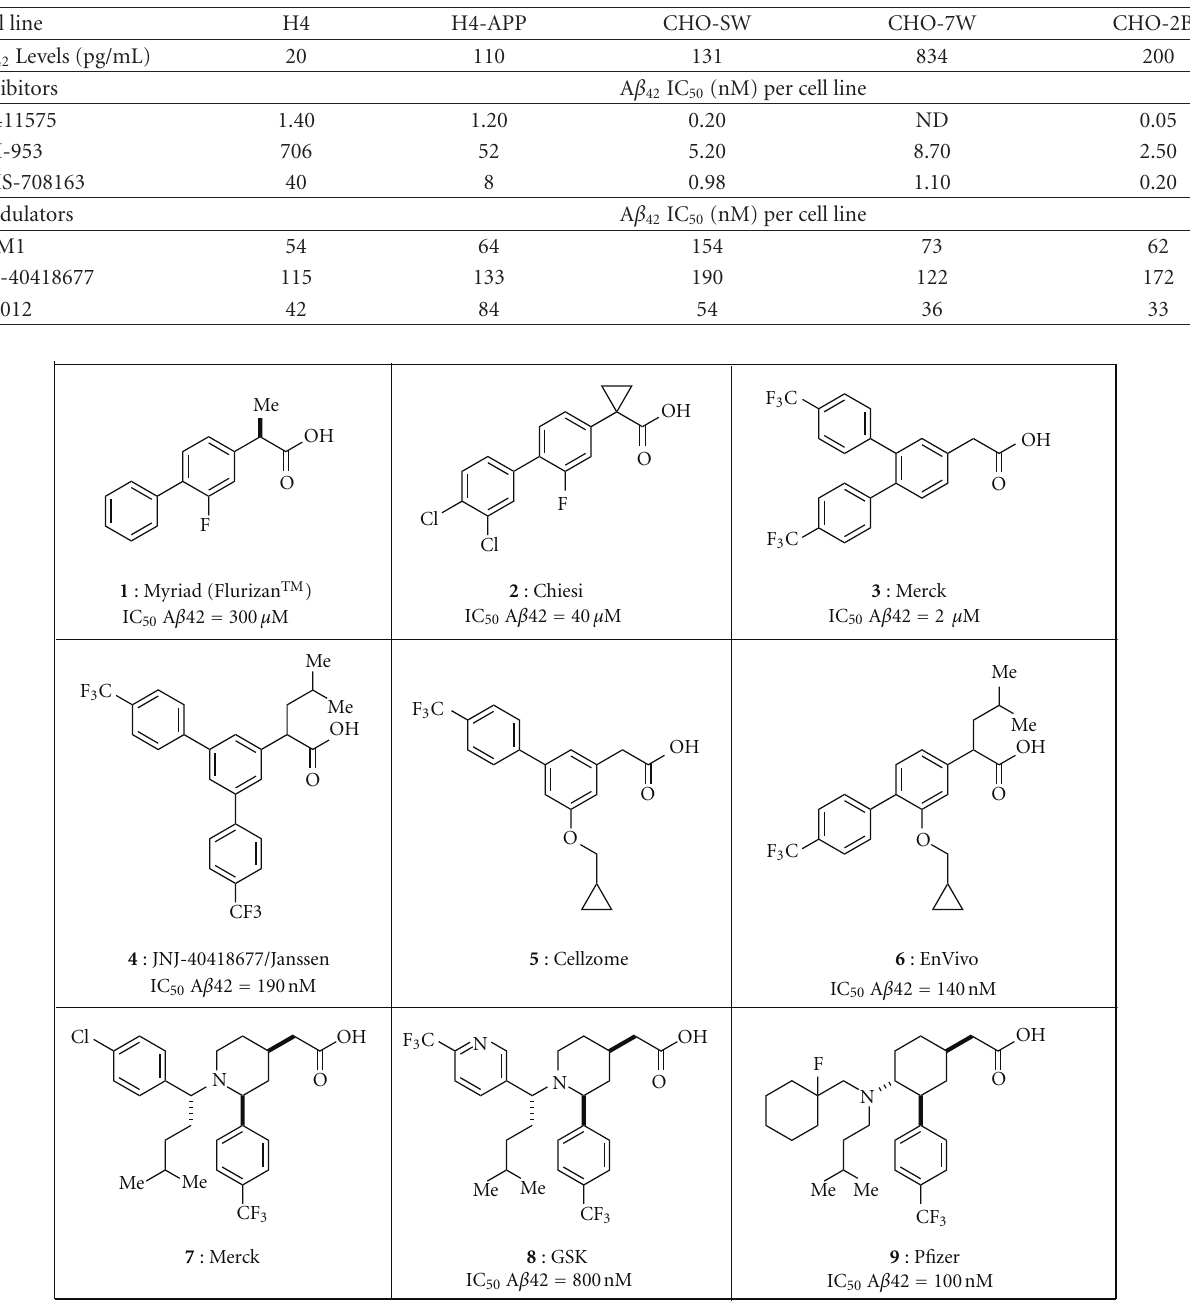
Figure 2: Representative NSAID-inspired GSMs. Compounds 1–6 are aryl acetic acids [21–26], compounds 7 and 8 are piperidine acetic acids [27, 28] and compound 9 is a cyclohexane acetic acid